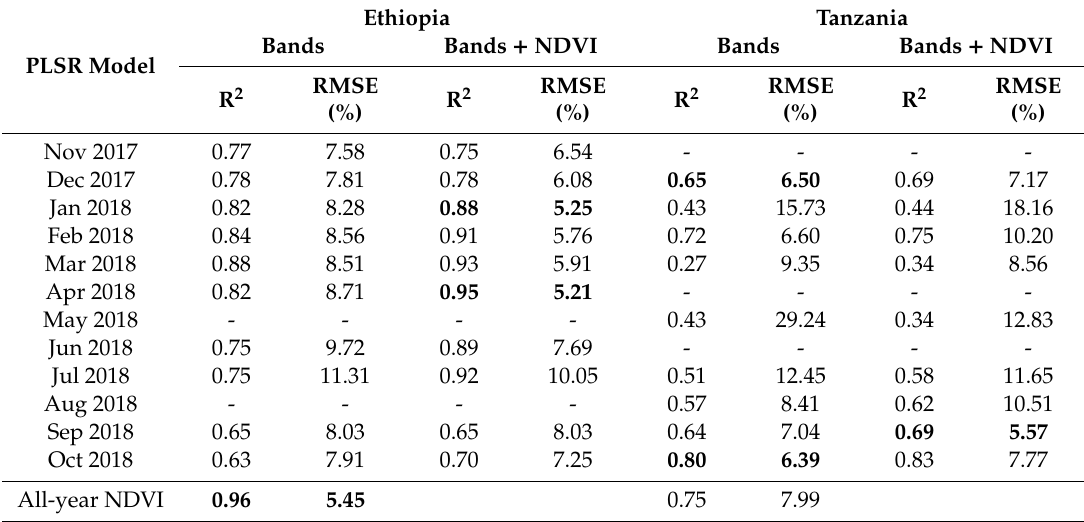
Table 5. R 2 and RMSE of the PLSR models for Ethiopia and Tanzania separately (Scenario 1). ‘-‘ means some plots were covered by clouds so R 2 and RMSE could not be calculated. In the all-year NDVI-regression in Ethiopia, May and August 2018 were left out, while in Tanzania, November 2017 and April and June 2018 were left out. The three best performing models for each study site are marked in